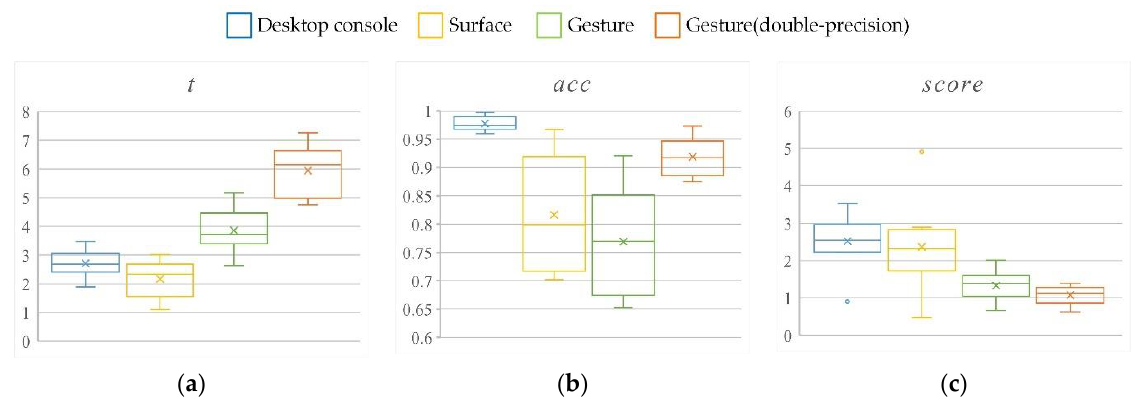
Figure 9. Boxplot of movement task results. (a) The time consumption. (b) Accuracy of interaction operation. (c) Score of interaction operations.